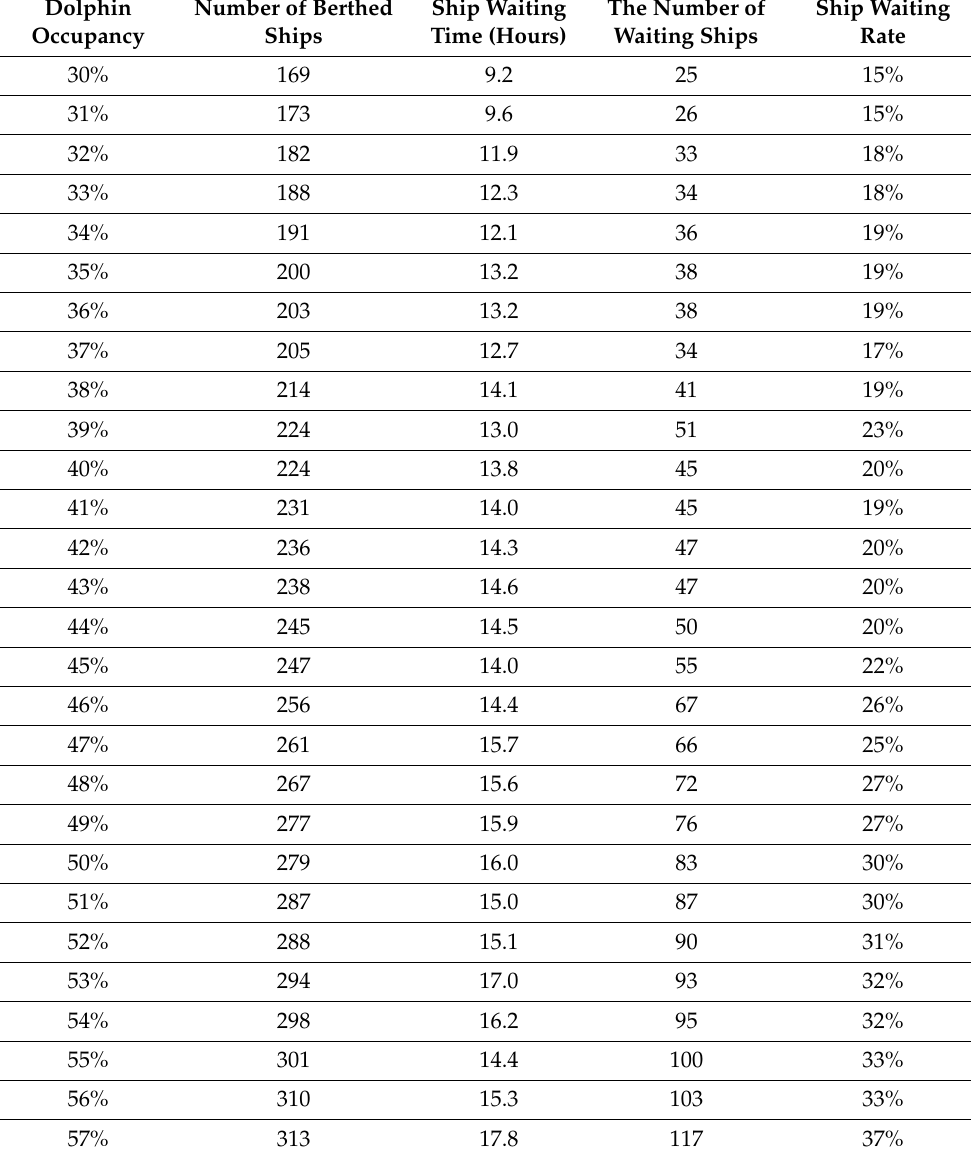
Table 5. Dolphin occupancy and ship waiting